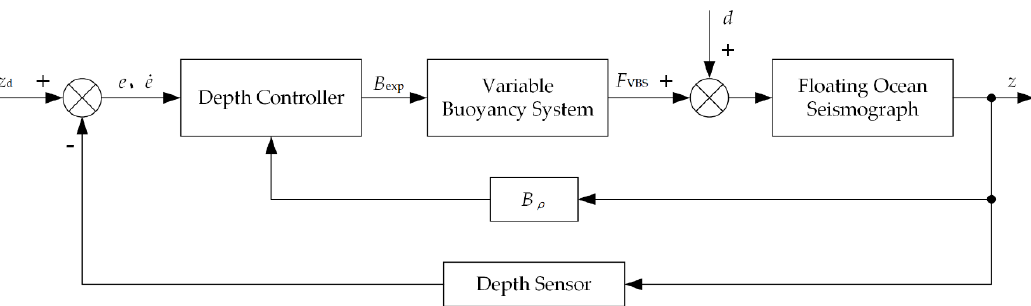
Figure 5. Depth control block diagram.